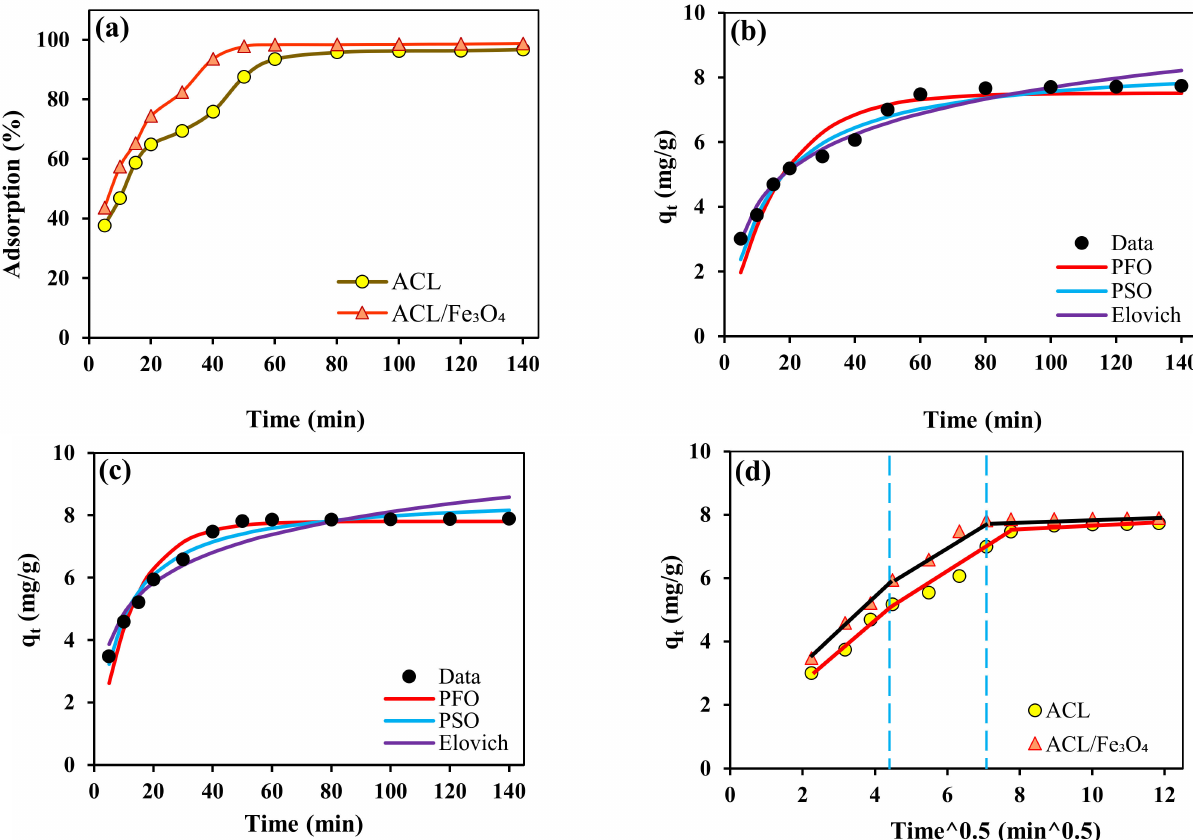
Figure 5. ( a ) contact time effect (pH = 9, temperature 25 ◦ C, adsorbent dose 1.25 g/L, initial CV concentration 10 mg/L), Nonlinear relationship of PFO, PSO and intraparticle diffusion kinetic models for ( b ) ACL, and ( c ) ACL/Fe 3 O 4 magnetic nanocomposite, and ( d ) linear relationship of Weber-Morris model for ACL and ACL/Fe 3 O 4 magnetic